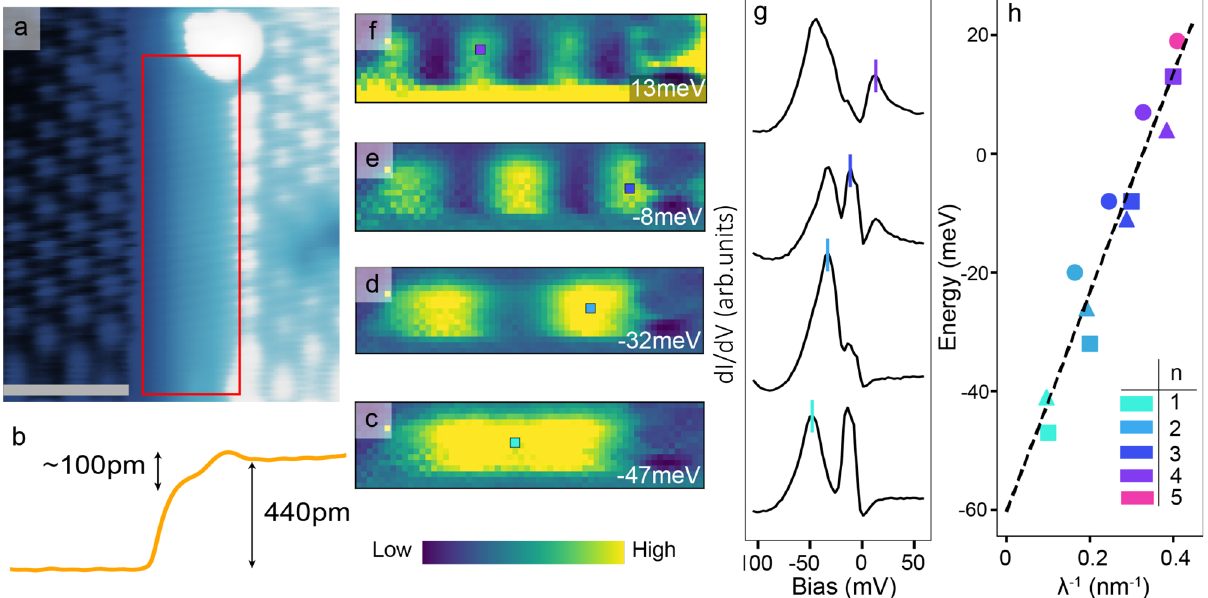
Fig. 3 Observation of linearly dispersing bound states on Co 3 Sn Kagome terrace. a Topography of a step edge between two S surfaces containing a small terrace of the Co 3 Sn plane, indicated by the red rectangle. ( I = 20pA, V = − 200mV). The gray inset scale bar indicates 2nm. b Line pro fi le of the step edge. Total step height is consistent with one-third of a lattice constant c or approximately 440pm. The terrace is approximately 130pm below the top S surface. c – f Density of state maps of the region enclosed by the red rectangle in a at energies for each quantum well like state. The color indicates the value of DOS. ( I = 200pA, V = − 200mV). g Spectra at locations of the high density of states for each quantum well-like state indicated by small squares in c – f starting at n = 1 at the bottom to n = 4 at the top. Spectra are offset for clarity. A small vertical line indicates the peak associated with the energy of the state. h Energy versus inverse wavelength relation for states found on three Co 3 Sn terraces. The states shown in the fi gure are represented by squares, while states from the two other terraces are circles and triangles. The linear dashed line is provided as a guide to the eye. The inverse wavelength is calculated assuming the distance between peaks is one